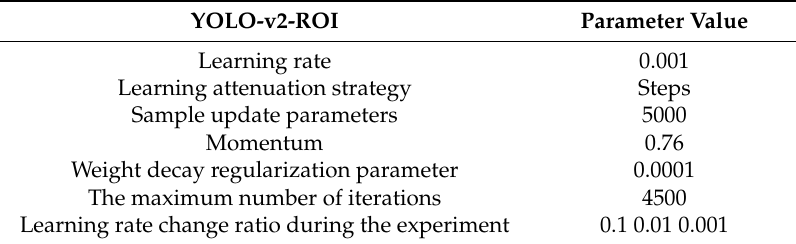
Table 2. Training